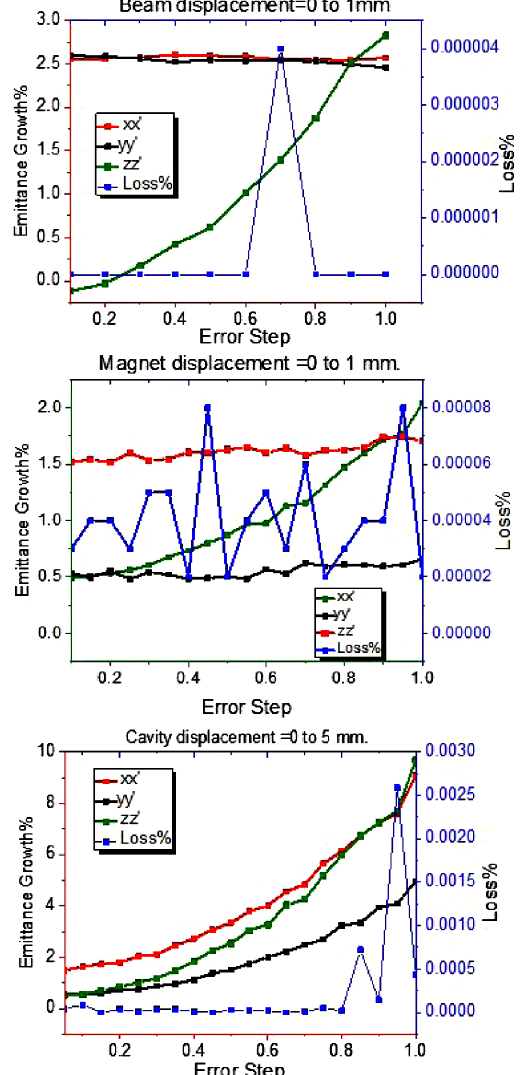
FIG. 45. Emittance growth as a function of error step for different types of error studies.